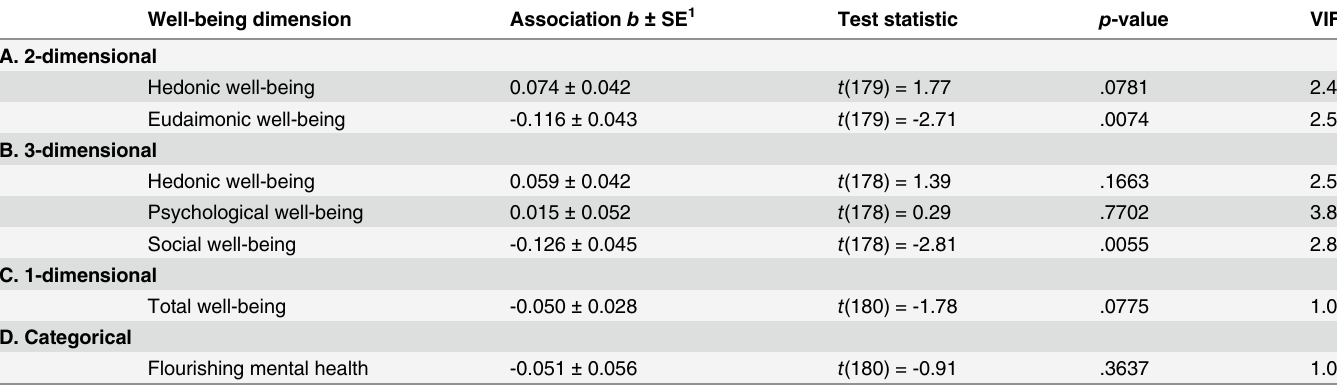
Table 3. Association of well-being with gene expression: pooled Discovery and Confirmation Studies.